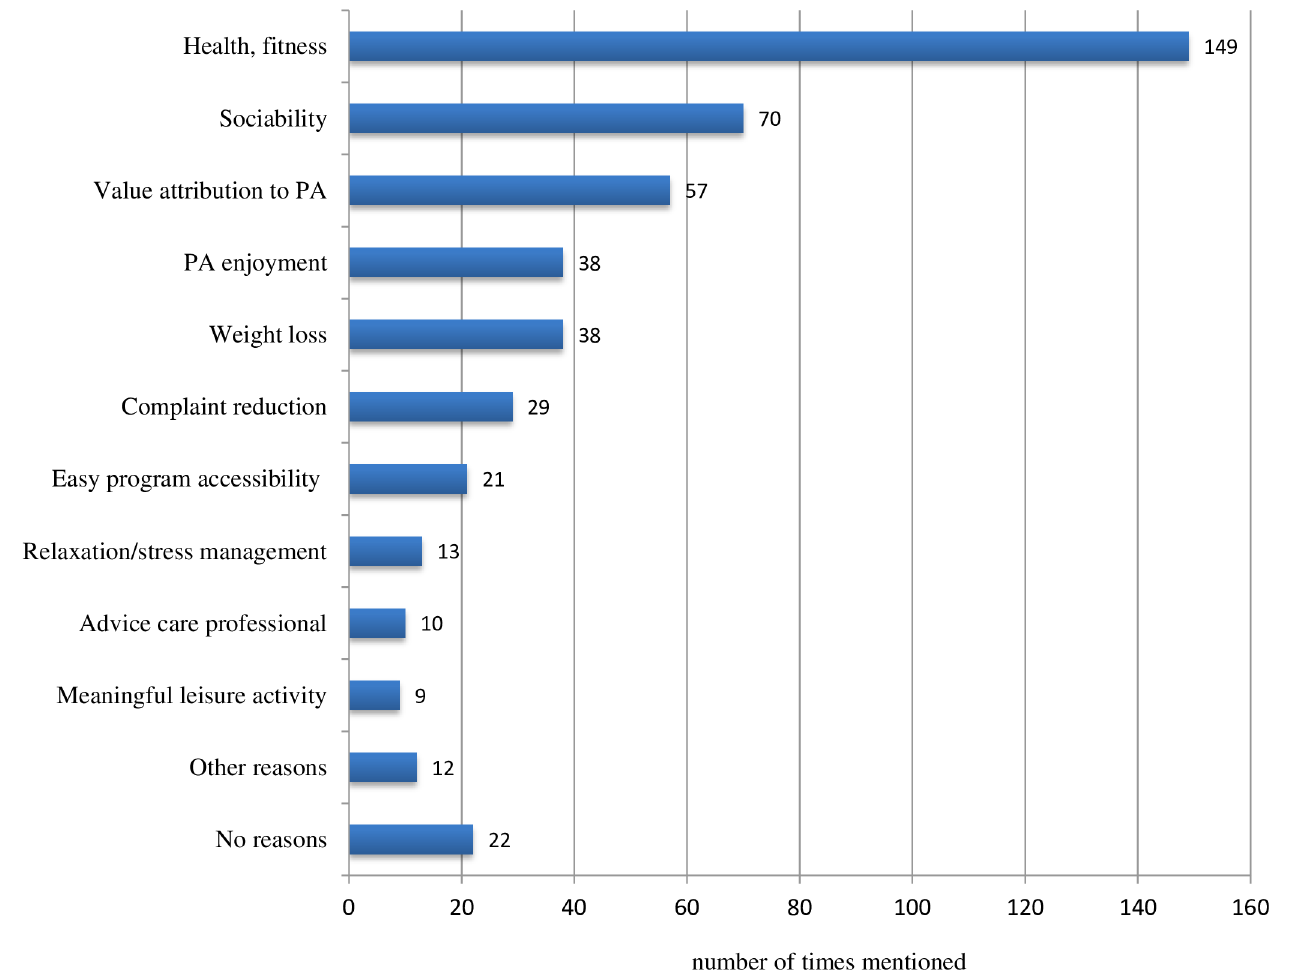
Fig 3. Self-reported participant motivations for joining CBHEPA programs (n =